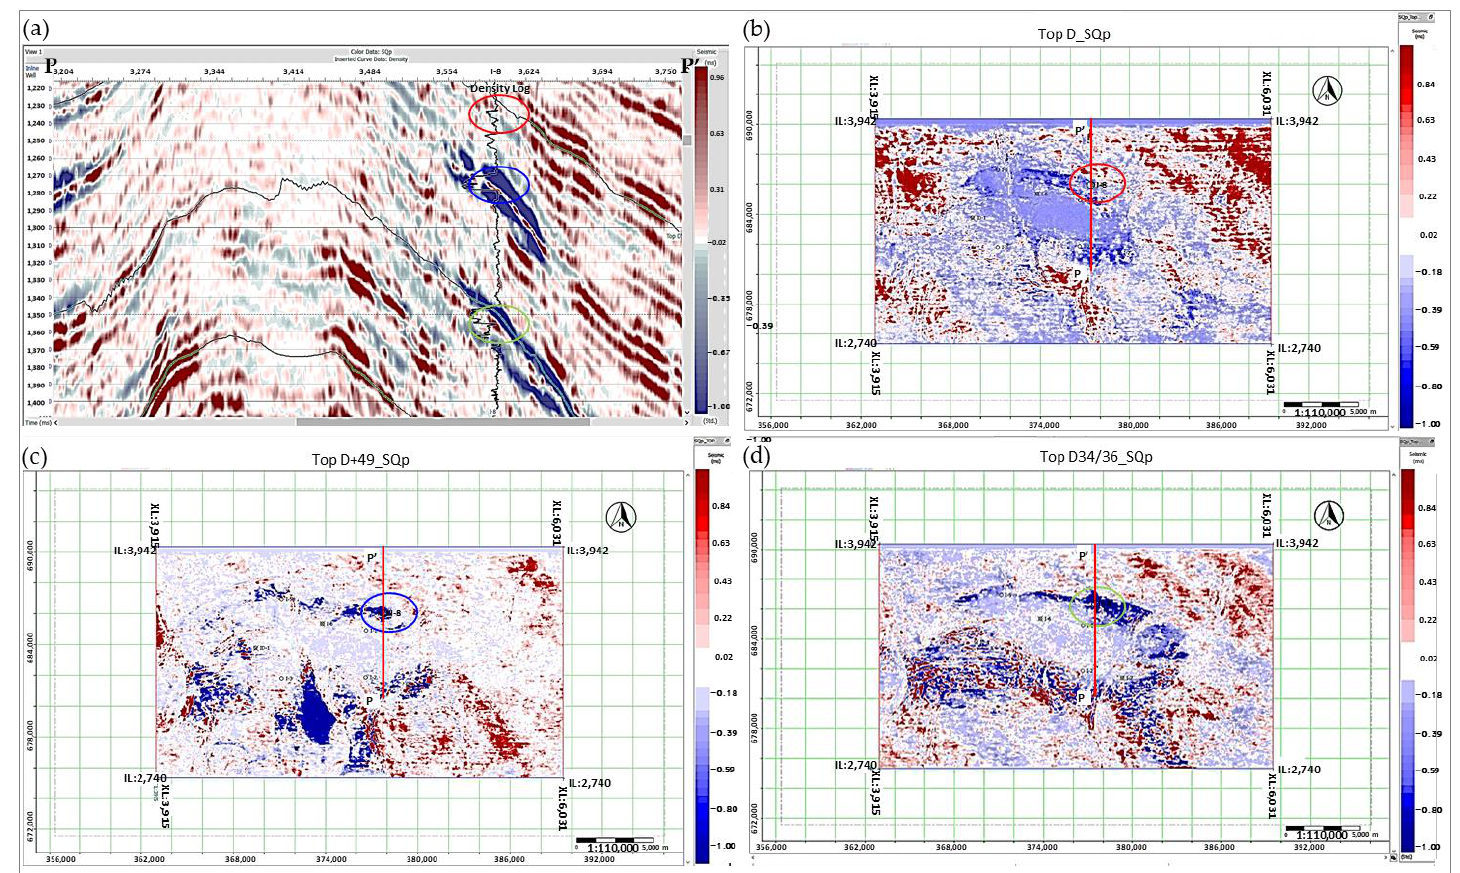
Figure 13. Application of SQp attribute to distinguish facies. ( a ) Seismic section which was penetrated by I-8 well log showed that the sand area was interpreted as a blue color. The red circle was top D, the blue circle was the top D+49, and the green circle was the top D34/36. These circles illustrated the consistency result between SQp attribute application and density characteristic for facies prediction, ( b ) SQp attribute slice for Top D zone. The red circle was the sand area for D interval, which was penetrated by I-8 log, ( c ) seismic attribute slice for top D+49 ms zone. The blue circle was the sand area for D+49 interval, which was penetrated by I-8 log, and ( d ) seismic attribute for top D34/36 zone. The green circle was the sand area for D34/36 interval, which was penetrated by I-8 log.